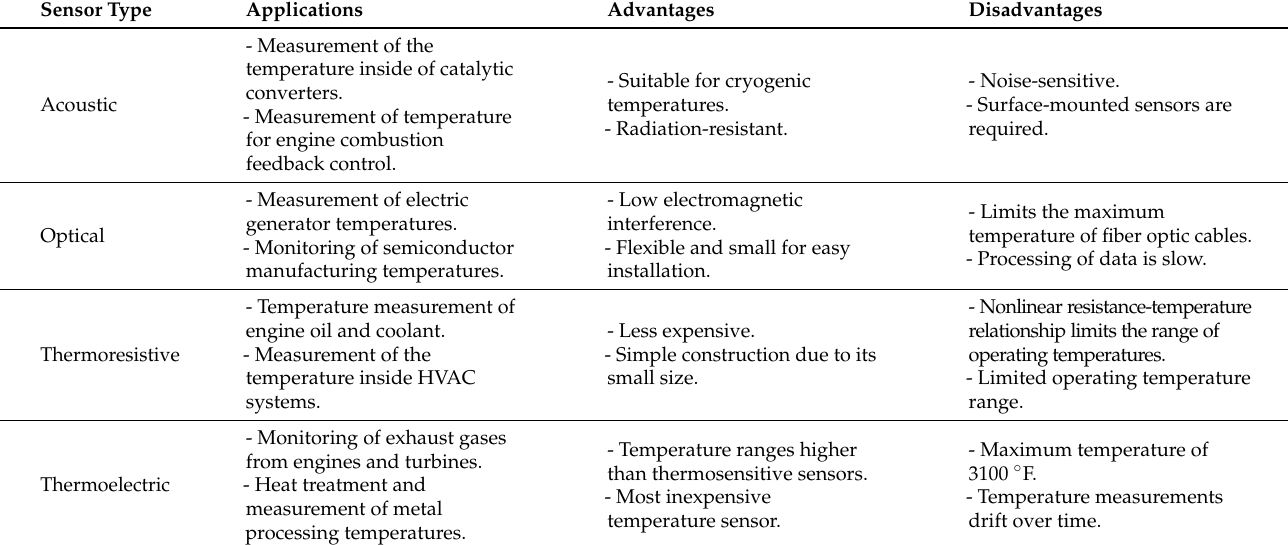
Table 23. Temperature sensors.